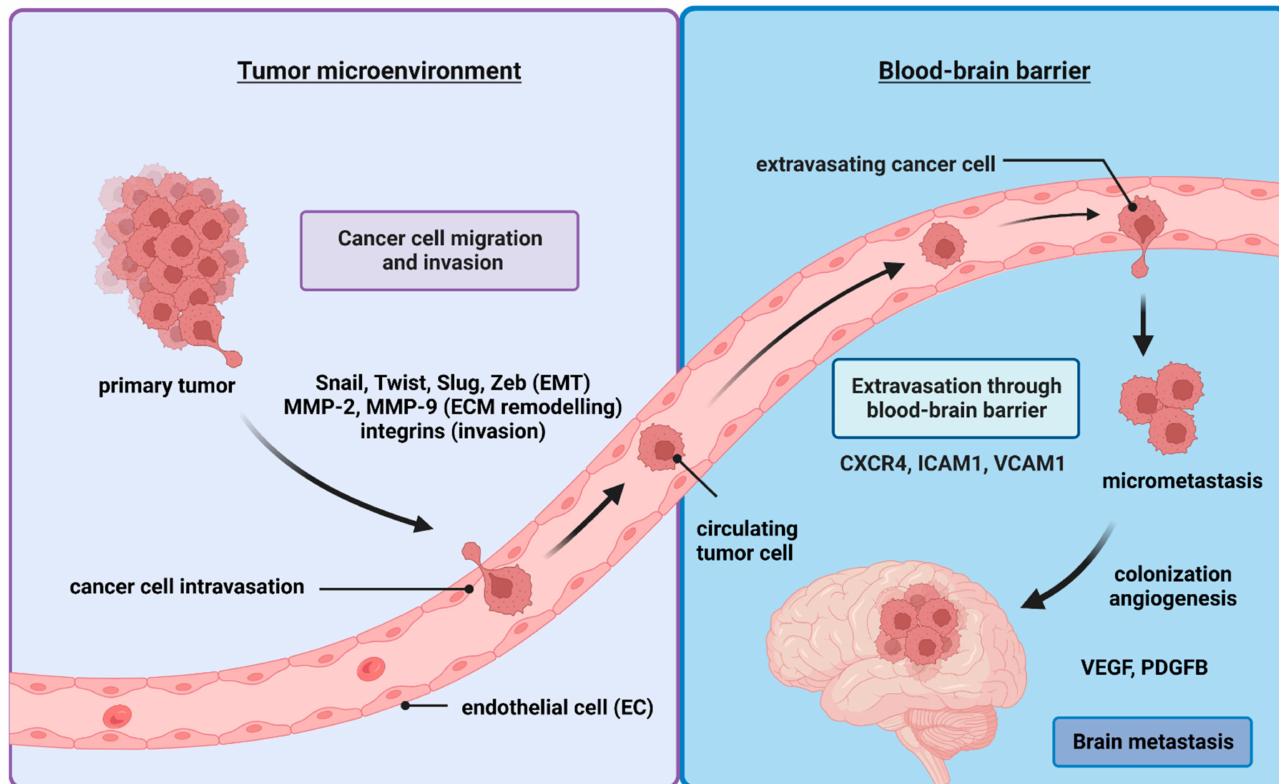
Figure 1. The major stages of metastasis formation in the brain. Metastatic cells pass through several phases in order to colonize the brain. First, they acquire a stem-cell-like phenotype and shed their epithelial phenotype in a process called epithelial–mesenchymal transition (EMT). Once the EMT phase has started, cancer cells begin degrading the ECM and reshaping it to form a hole the approximate size of one cancer cell. After that, they have to choose which intravasation passage they take. There is a need for better understanding of the factors affecting cancer cells’ migration routes. Nevertheless, after finishing the intravasation phase, the cancer cells initiate the extravasation phase, where they infiltrate the blood–brain barrier (BBB), and, finally, they reverse their status from stem-cell-like back to the epithelial-like phenotype as they start to colonize the brain. The interaction between cancer cells and their environment constitutes a large mine of therapeutic opportunities aimed at halting cancer cells’ invasion of the brain. Created with